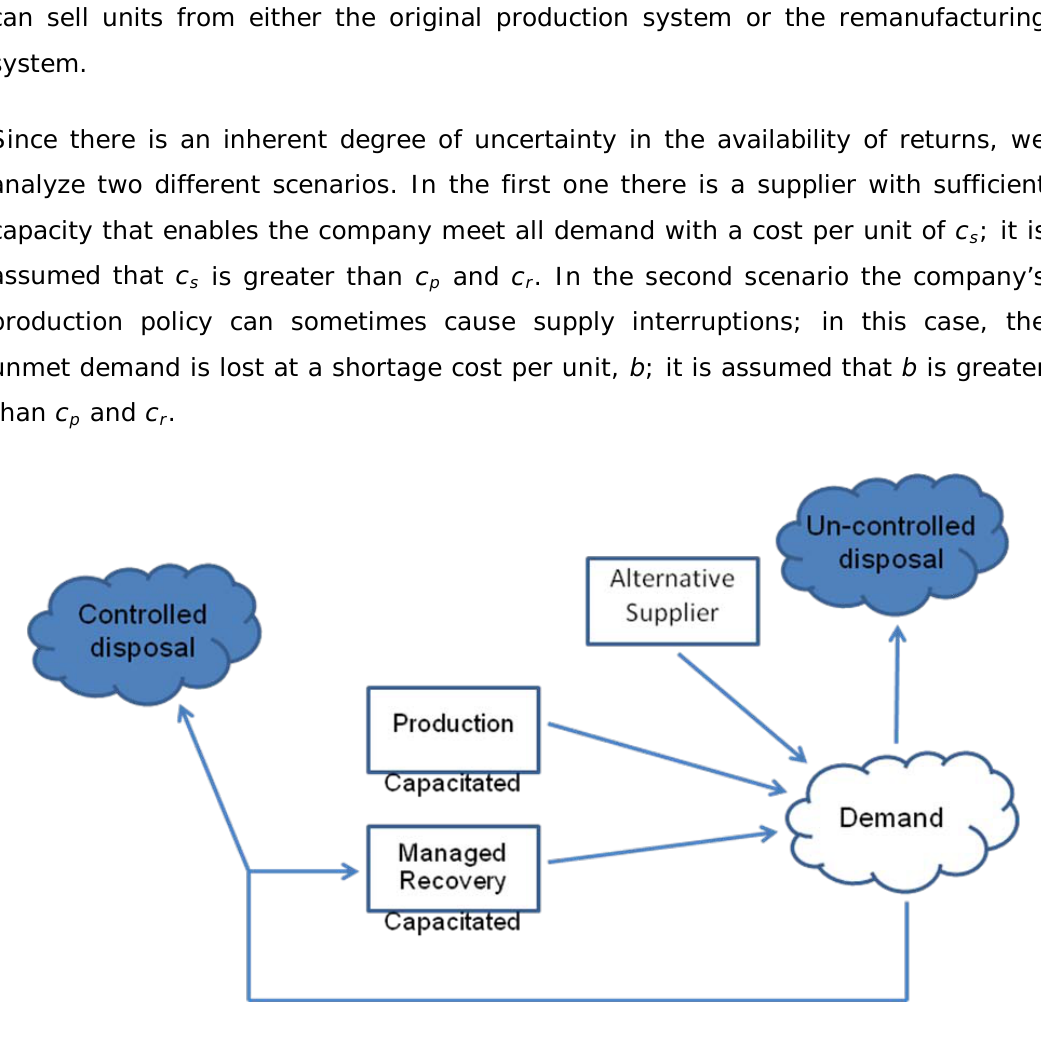
Figure 1. “Schematic representation of the system”. Source: Own